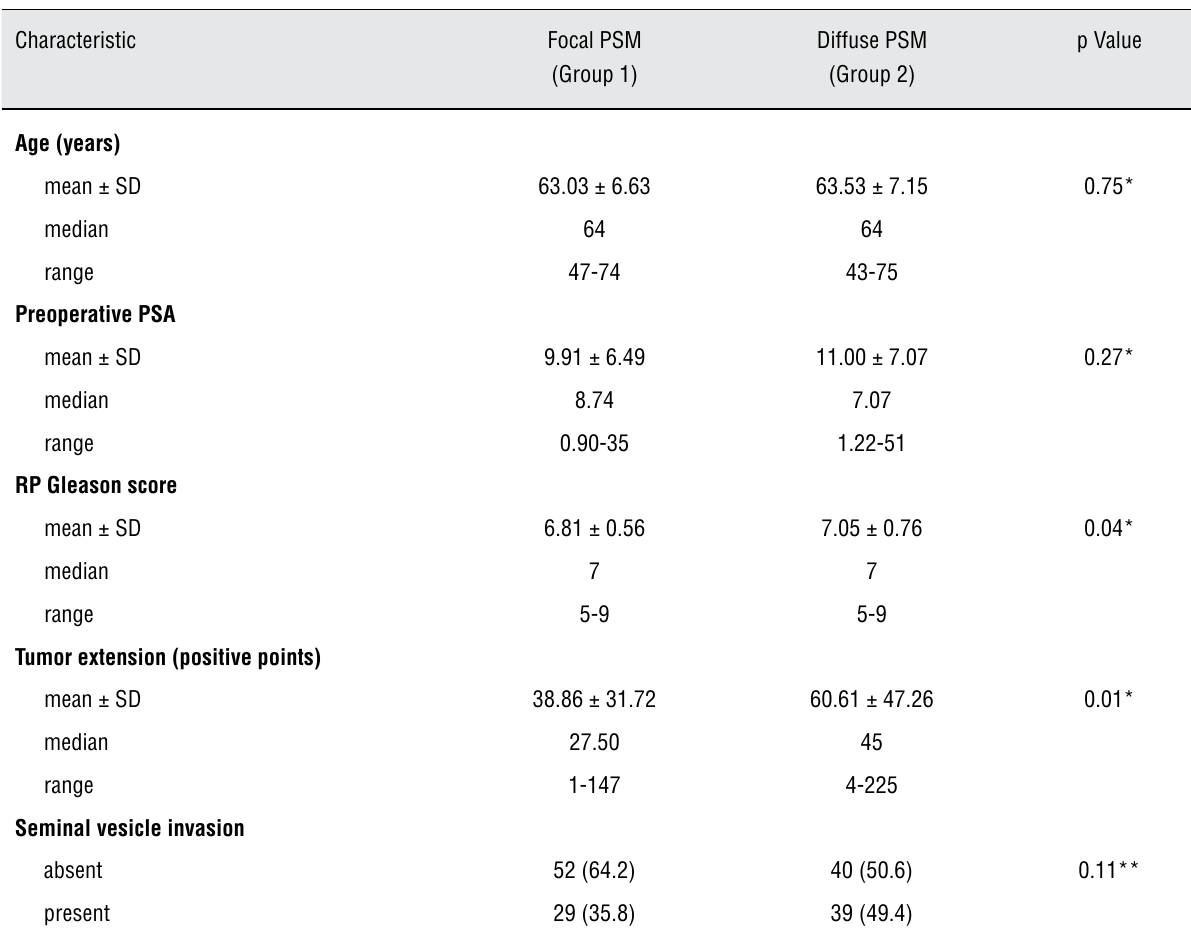
Table 2 - Clinicopathological features comparing 81 patients with focal PSM (Group 1) vs. 79 patients with diffuse PSM (Group 2).